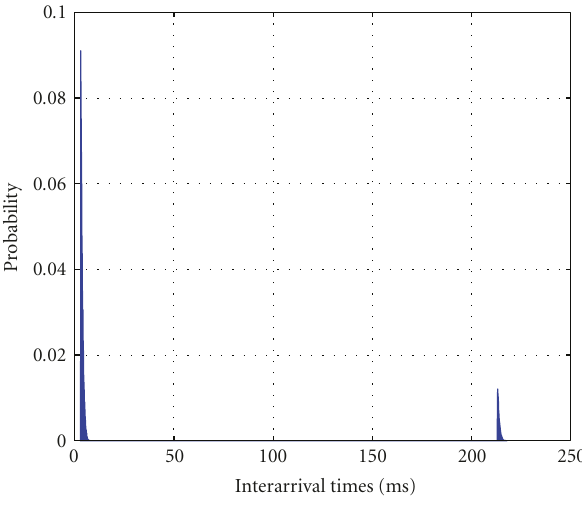
Figure 5: SMAC PDF for 15% utilization.